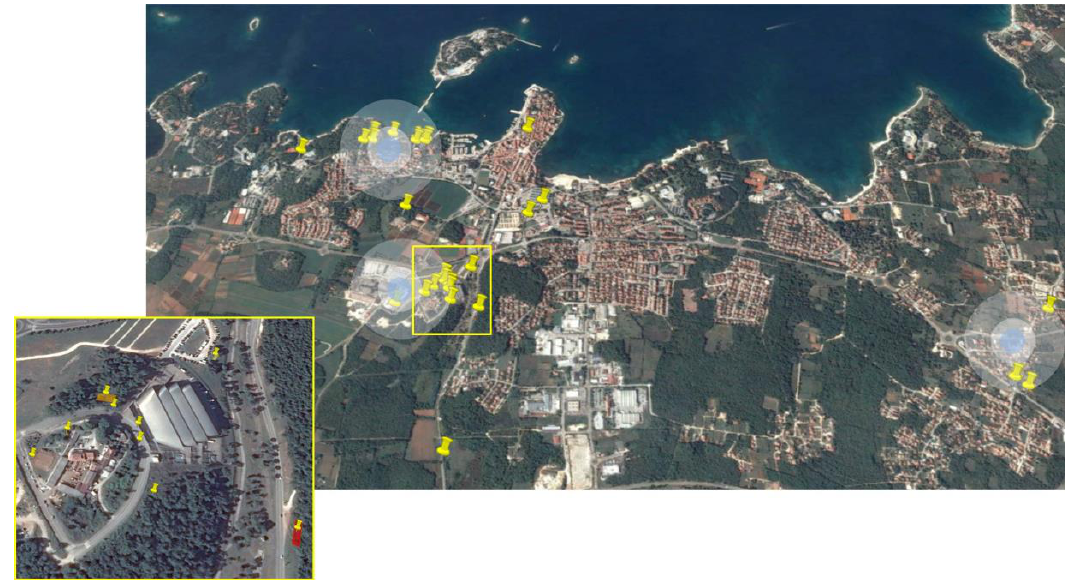
Figure 4. Global view of the satellite map of the A. altissima infestation in Poreč City as shown by Google Earth Pro software. Pins (yellow) and polygons (orange, red) indicating infestation are shown. Transparent circles represent locations of source A. altissima trees and distribution of invasion sites.